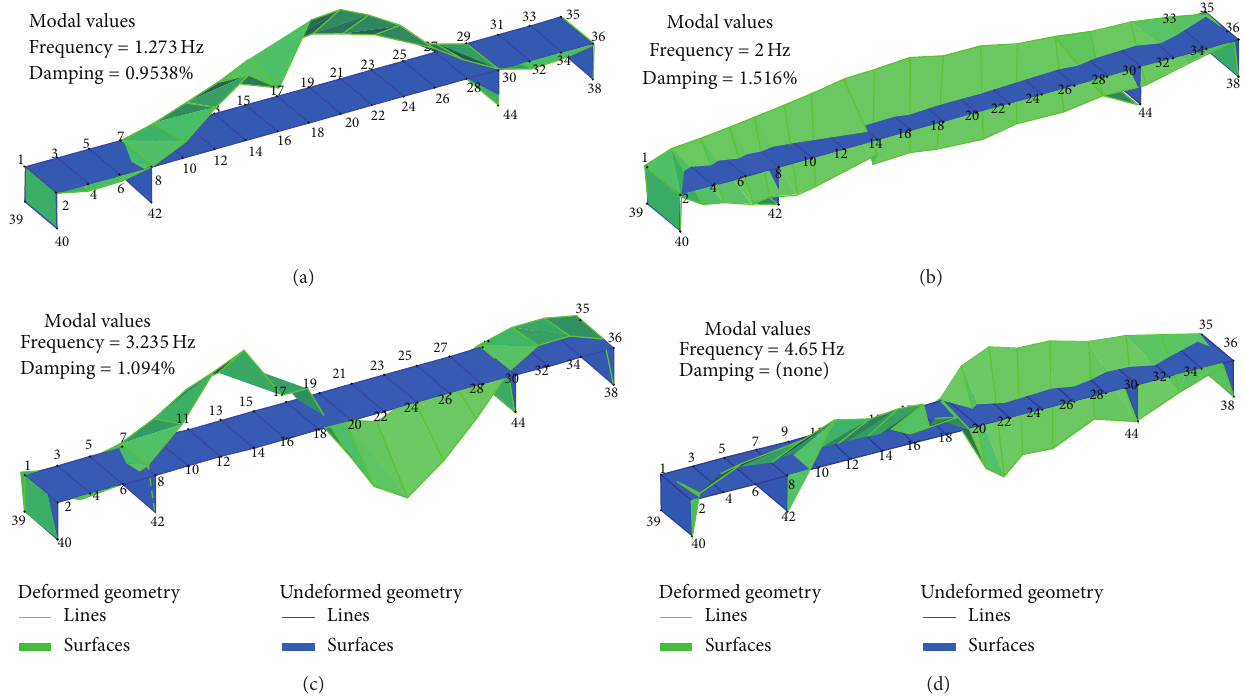
Figure 23: Vibration modes obtained by SSI (Artemis): (a) 1st vertical mode; (b) 1st transversemode; (c) 2nd vertical mode; (d) 2nd transverse mode.